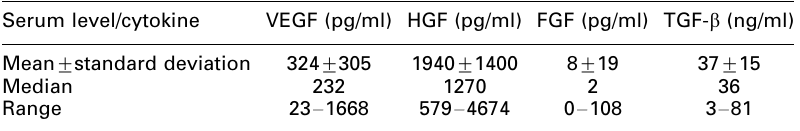
Table 4. Serum levels of VEGF, HGF, FGF and TGF- b in MM patients Serum level/cytokine